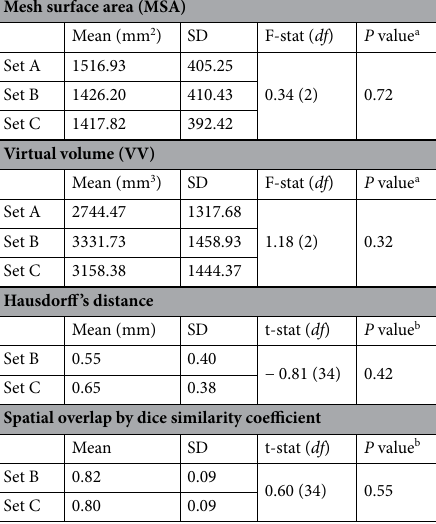
Table 2. Comparison of virtual properties of obturator bulbs designed via Sets A, B and C. a One-way ANOVA, 3 equal groups (total n=54). P value set at 0.05. Kolmogorov–Smirnov test for MSA and VV is not significant ( P > 0.05) for all groups. Data is normally distributed. b Independent t-test, P value set at 0.05. All parameters for normal distribution met. Kolmogorov–Smirnov and Shapiro–Wilk tests not significant ( P > 0.05). Levene test for HD and DSC were 0.593 and 0.994, respectively. HD and DSC were obtained by taking Set A as comparison